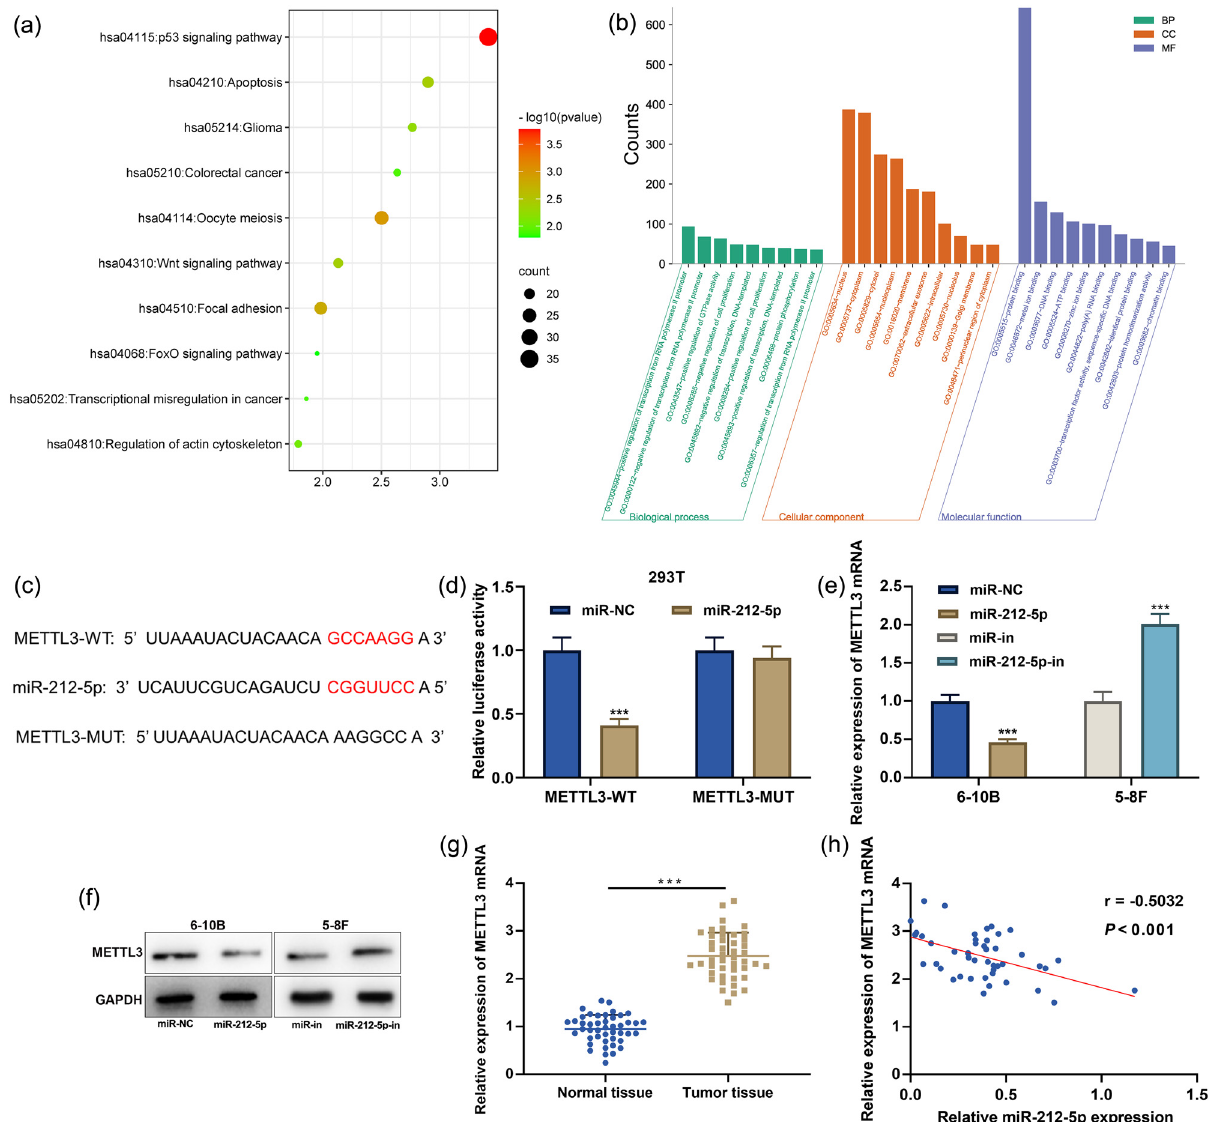
Figure 3: METTL3 is a target of miR - 212 - 5p. ( a ) The pathway enrichment analysis on the downstream target gene set of miR - 212 - 5p was conducted by the KEGG analysis. ( b ) The functional enrichment analysis on the downstream target genes of miR - 212 - 5p was conducted by the GO analysis. ( c ) Binding sequences of METTL3 mRNA 3 ′ UTR wild type or its mutant to miR - 212 - 5p were showed. ( d ) Dual - luciferase reporter gene assay was used to verify the e ff ect of overexpression of miR - 212 - 5p on the luciferase activity of METTL3 - WT and METTL3 - MUT. ( e and f ) The expression of METTL3 mRNA and protein in 6 - 10B or 5 - 8F cells transfected with miR - 212 - 5p mimics or inhibitors were detected by qRT - PCR and western blot. ( g ) The expression of METTL3 mRNA in NPC tissues and adjacent tissues was detected by qRT - PCR. ( h ) The correlation between METTL3 expression and miR - 212 - 5p expression in NPC tissues was detected by Pearson ’ s correlation analysis. ***P <